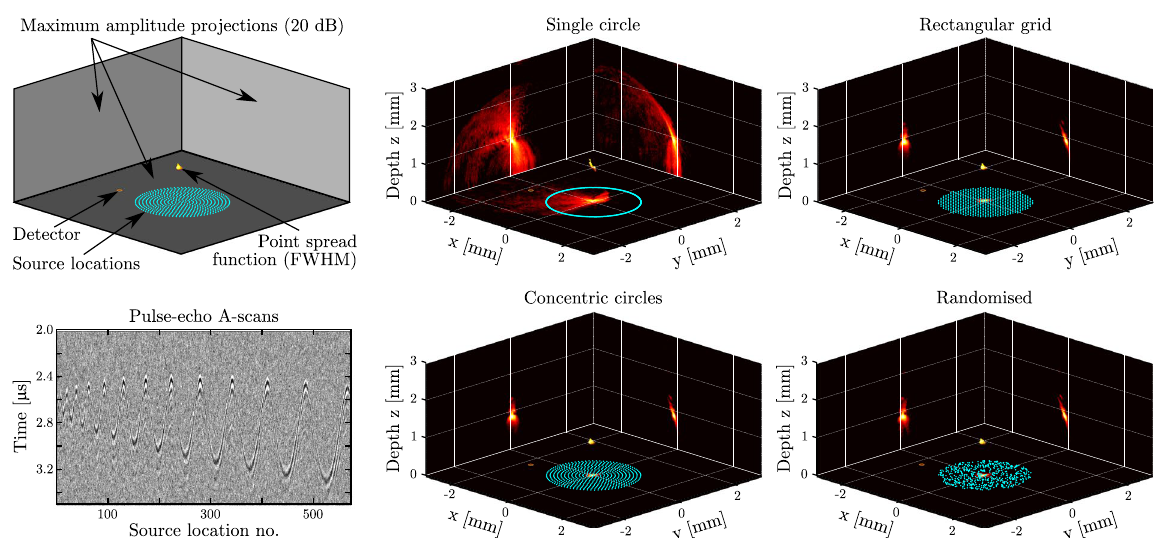
Figure 3. Images of the tip of a pushpin (see Fig. 4) obtained with the all-optical, three-dimensional (3D) pulse-echo ultrasound imaging system. Light was focussed sequentially into areas corresponding to each source location, and pulse-echo signals originating from each source location were recorded using an optical acoustic receiver and subsequently reconstructed into a 3D image. Top left: Schematic highlighting the information contained in the two rightmost columns. The source locations are indicated in light blue; the receiver in orange. The volumetric render shows the full-width-at-half-maximum (FWHM) isosurface that corresponds to the spatial point spread function. The three panels show the maximum amplitude projections along each spatial axis, displayed on a logarithmic scale with a 20 dB dynamic range. Bottom left: Pulse-echo A-scans recorded (using 10 averages) using a scan pattern consisting of fourteen equidistant concentric circles (573 source locations), where the circles were scanned in order of increasing radius. Middle and right columns: Imaging results for four different illumination patterns. In a clock-wise orientation: a single circle along the outer edge of the acoustical aperture (573 source locations), an equidistant rectangular grid covering the full acoustical aperture (576 source locations), a randomised pattern covering the full acoustical aperture (573 source locations), and a pattern comprising fourteen equidistant concentric circles (573 source